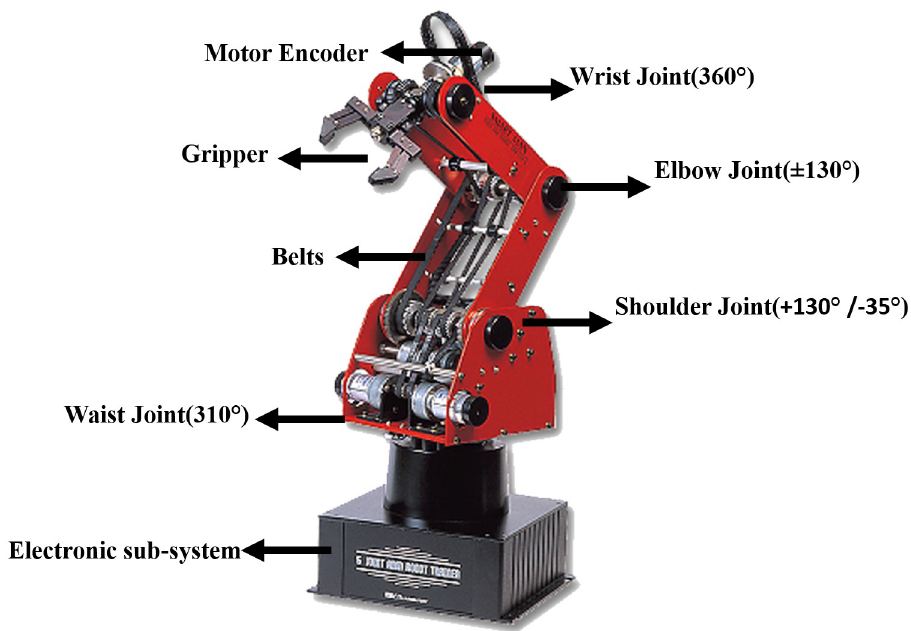
Fig 6. AUTAREP manipulator ED-7220C showing various joints with their Range Of Motion(ROM).